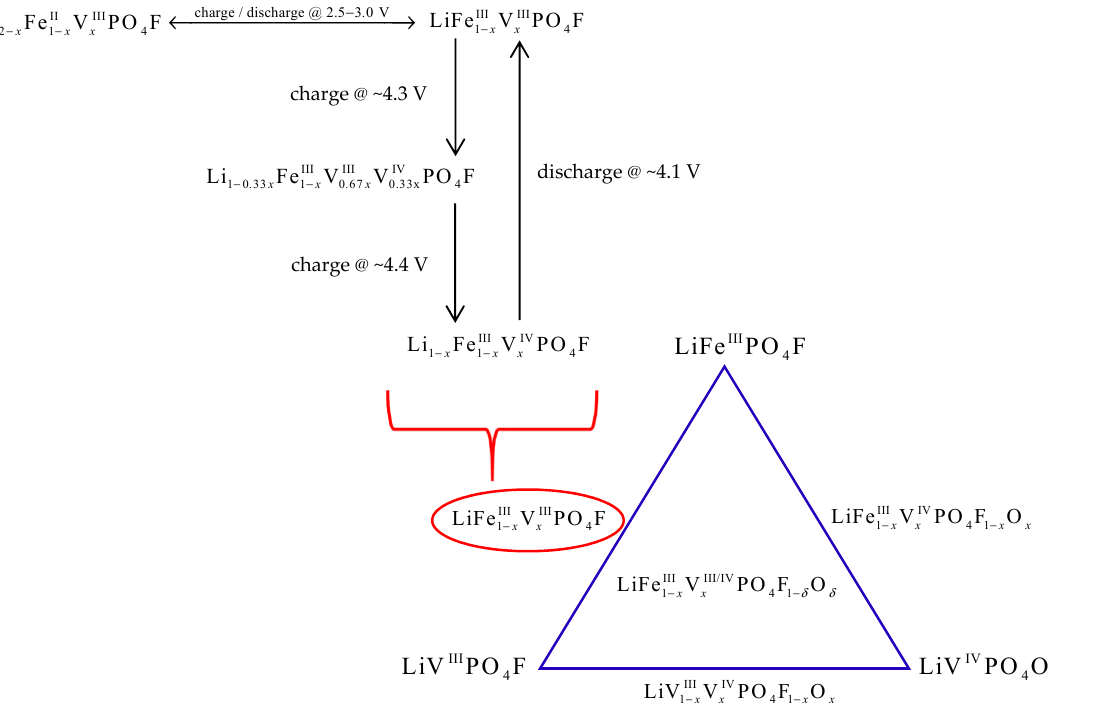
Figure 5. CV curves of LiFe 0.5 V 0.5 PO 4 F and LiFe 0.3 V 0.7 PO 4 F cells with different sweep rates of 0.1/0.2/0.3/0.4/0.5 mV s –1 for 15 cycles in the range of 2.0 − 3.6 V ( a ) and 3.0 − 4.5 V ( b ).